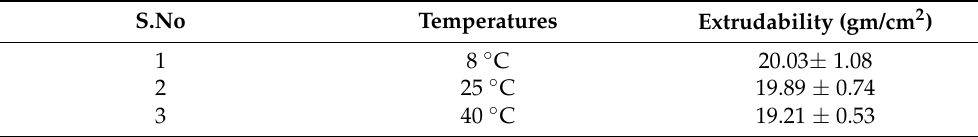
Table 5. Extrudability of optimized emulgel formulation at different temperatures.